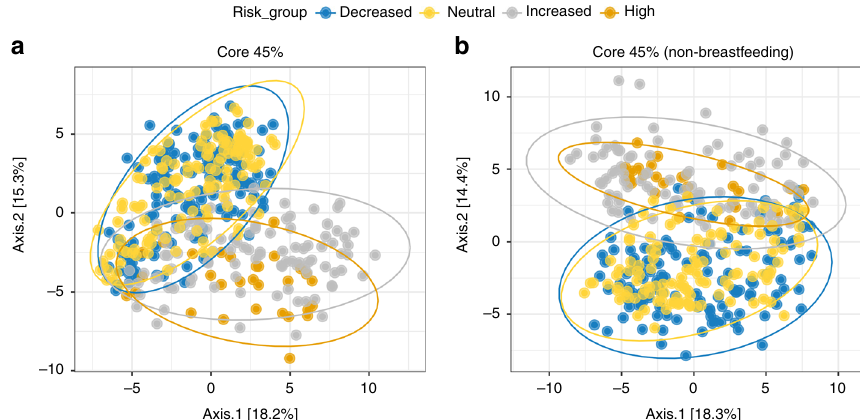
Fig. 3 Prevalence uncovers unique clusters among the most shared ASVs by risk. a , b PCoA depicting inter-subject distances based on the binomial metric at 45% prevalence, both including participants breastfed at sample collection ( a ) and without participants breastfed at sample collection ( b ). Ellipses for each risk group are calculated based on a 95% con fi dence for